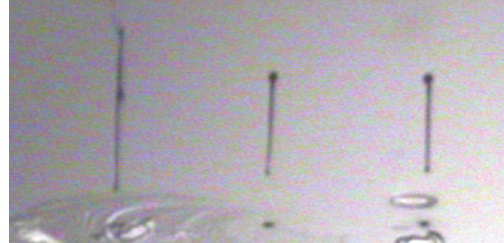
Figure 3: Inkjet drop formation of the PFFO nanoparticles